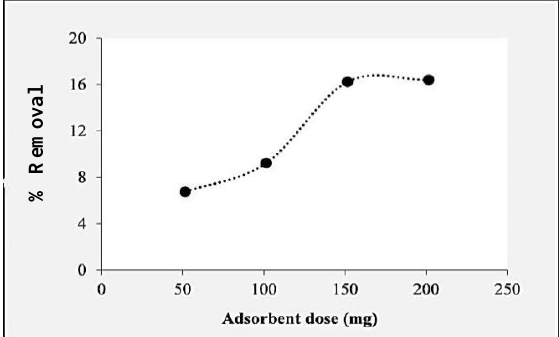
Figure 6. Effect of grafted gum on ferrous ion